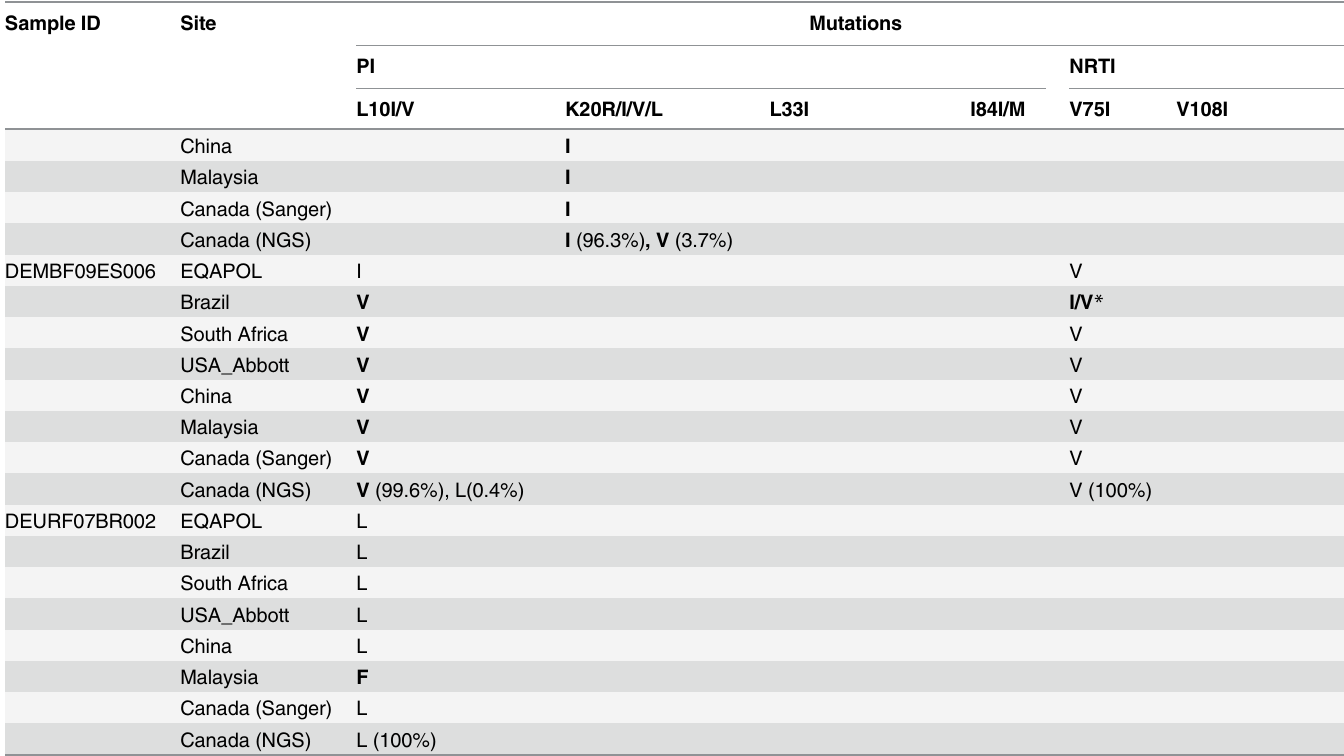
Discordant DRMs between each site and EQAPOL sequences are indicated in bold. Percentages of mutations determined by NGS at the Canada site are indicated in parenthesis. The positions are shown relative to those in the HXB2